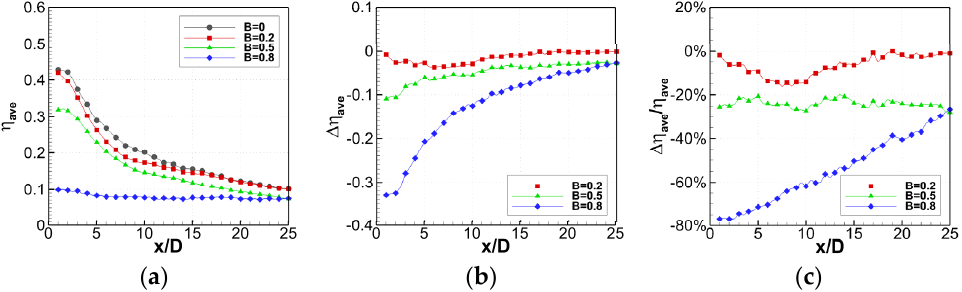
Figure 11. Effect of blockage ratio on spanwise averaged film effectiveness at M = 0.7. ( a ) η ave ; ( b ) ∆ η ave ; ( c ) ∆ η ave / η ave .